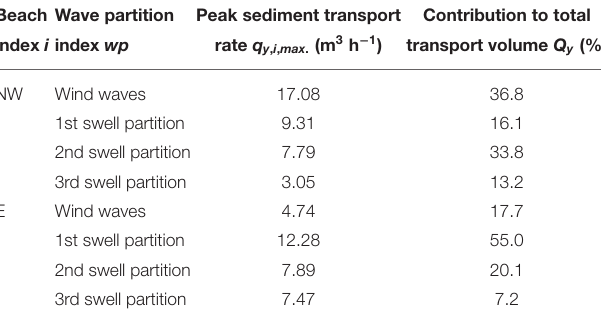
TABLE 3 | Peak transport rates q y , max and the contribution of each wave partition to the total transported sediment volume Q y in the CERC-formulation between 2016 and 2019 on the northern beaches Geiymiskih and Thoondu (NW: Figure 7 and E: Figure 8 ). Beach Wave partition Peak sediment transport Contribution to